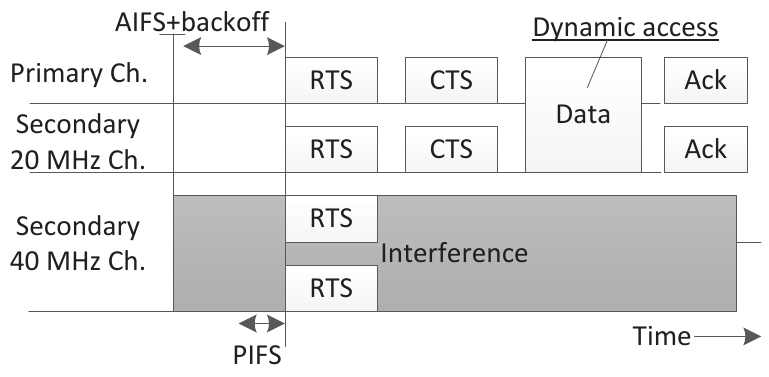
Figure 1. Dynamic bandwidth allocation mechanism; CTS: clear to send; RTS: request to send; Ack: acknowledgment; PIFS: point coordination function.